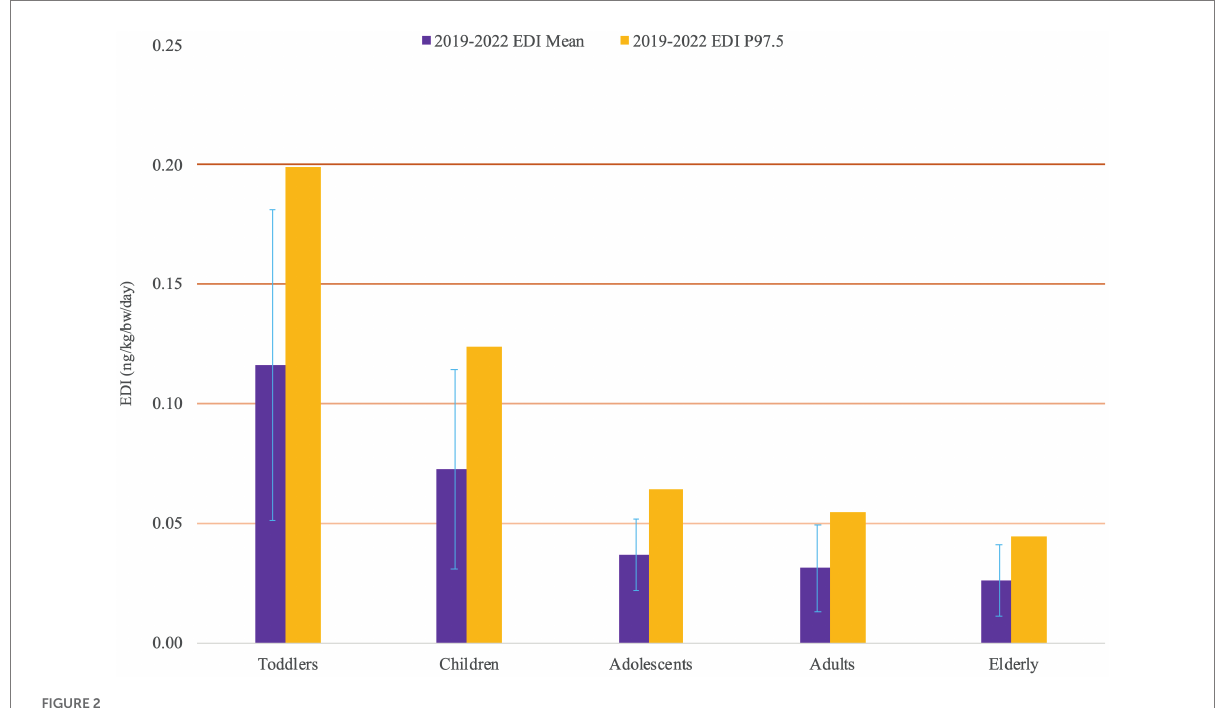
FIGURE 2 Median values of the mean and 97.5th percentile